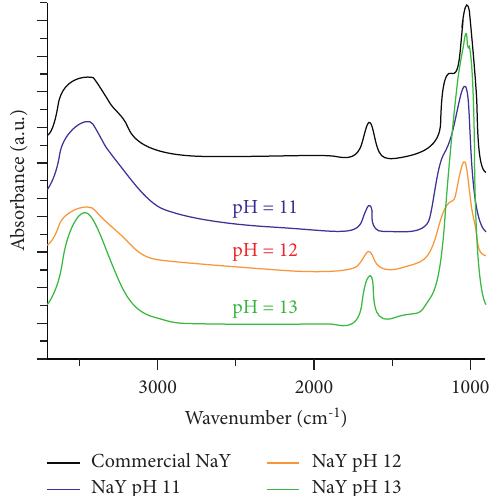
Figure 8: FT-IR spectrum of synthesized zeoliteNaY adopted from [16].